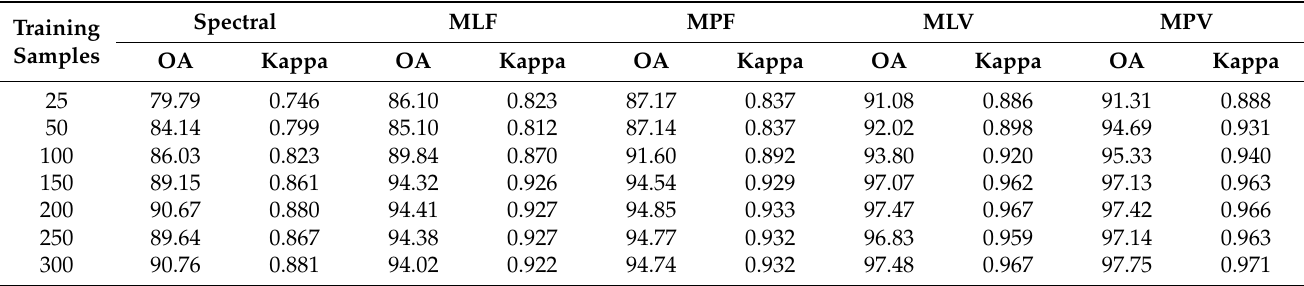
Table 7. OAs (%) and Kappa coefficients obtained by different methods for the Longkou dataset using RF with different numbers of training samples per